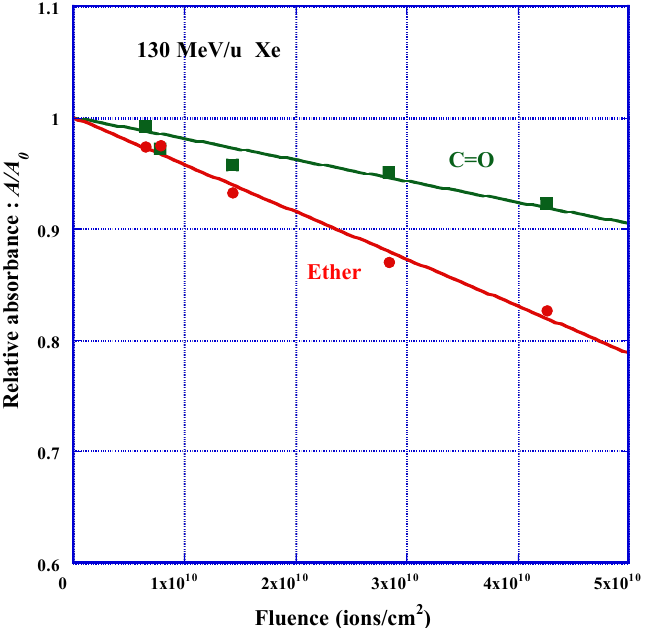
Figure 5. Reduction of the relative absorbance of ether and carbonyl in PADC against the fluence of 130 MeV/u Xe